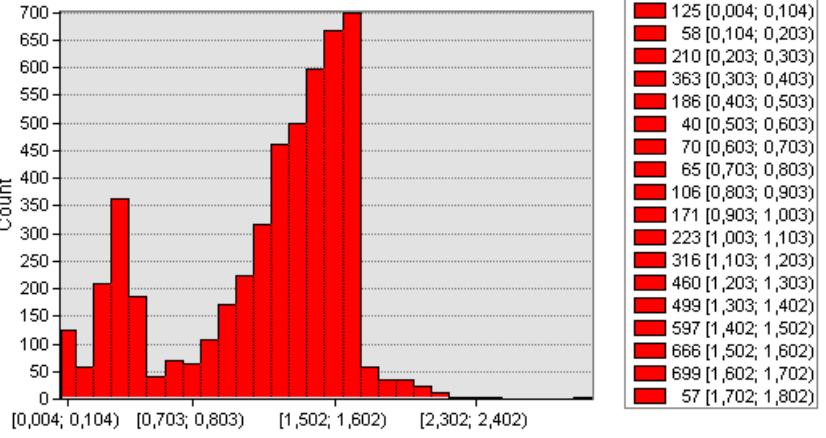
Figure 8. Histogram of 40 cm soil resistance values